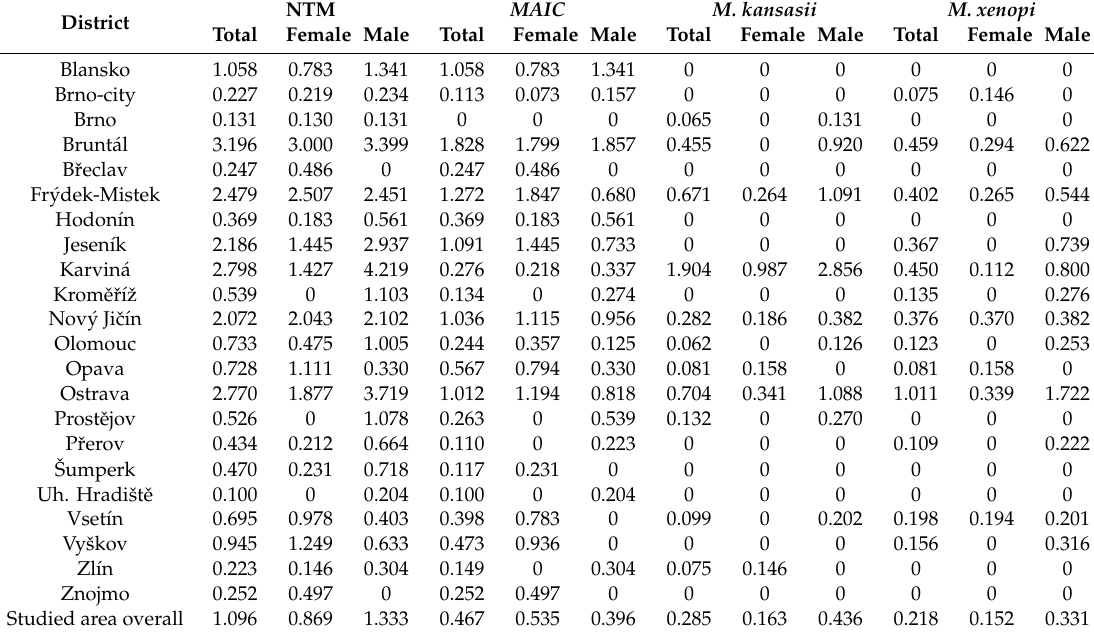
TableA1. TheincidenceofNTMdiseasesperdistrictsinthestudiedterritoryduringtheyears2012–2018.